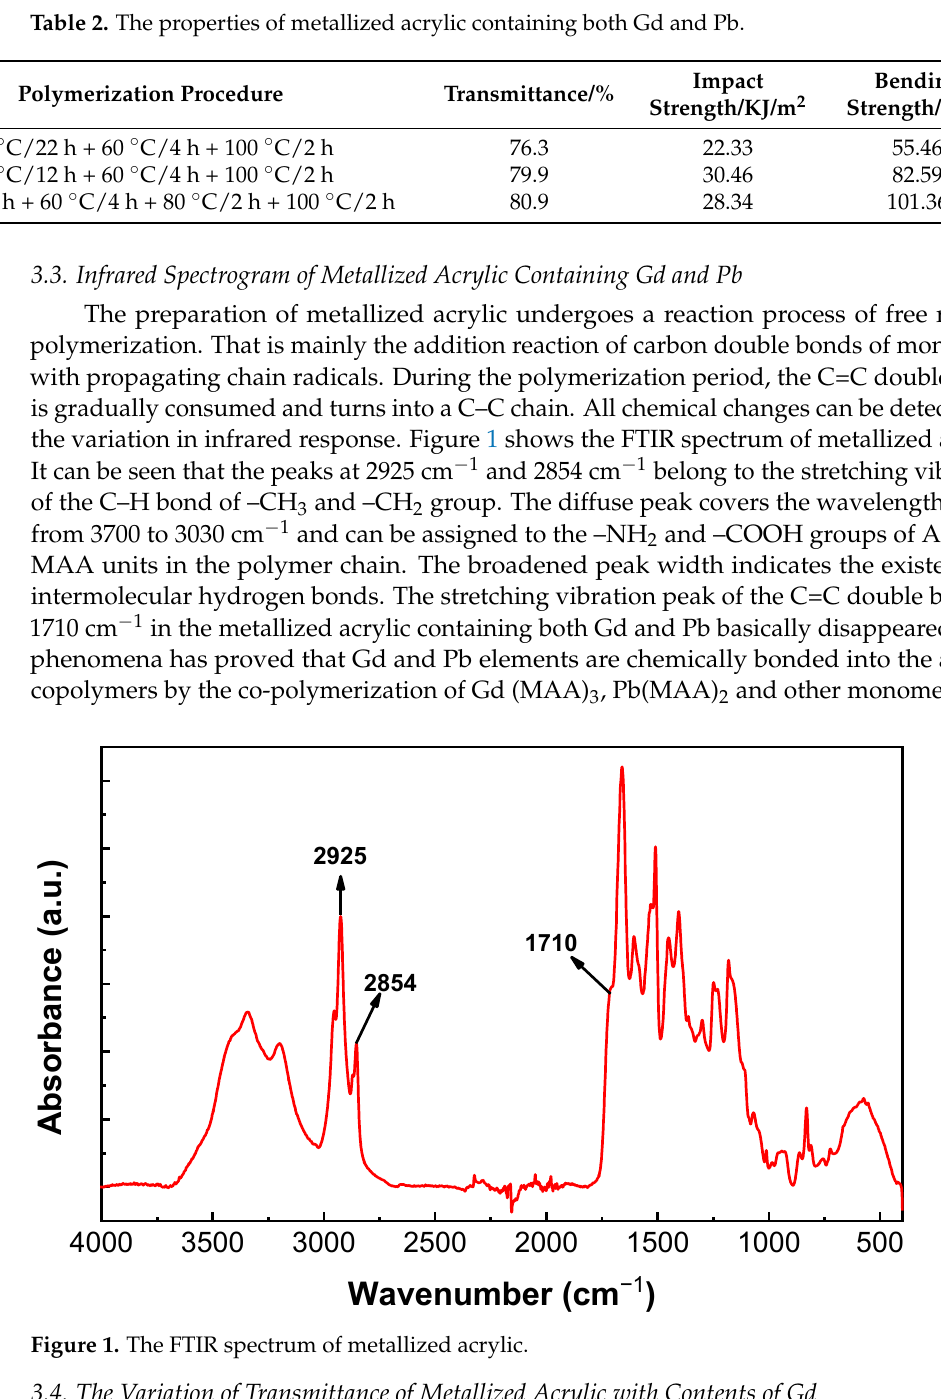
Table 2. The properties of metallized acrylic containing both Gd and Pb.